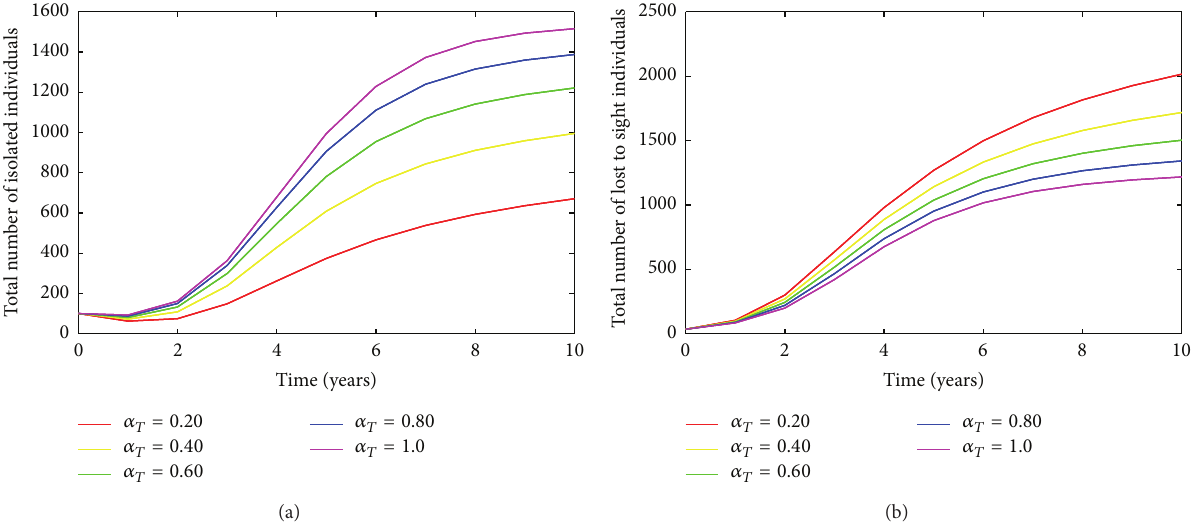
Figure 7: Simulation of model (2) as a function of time varying 𝛼 𝑇 for (a) total number of isolated individuals and (b) total number of individuals who are lost to follow-up. Parameter values used are as given in Table 2.